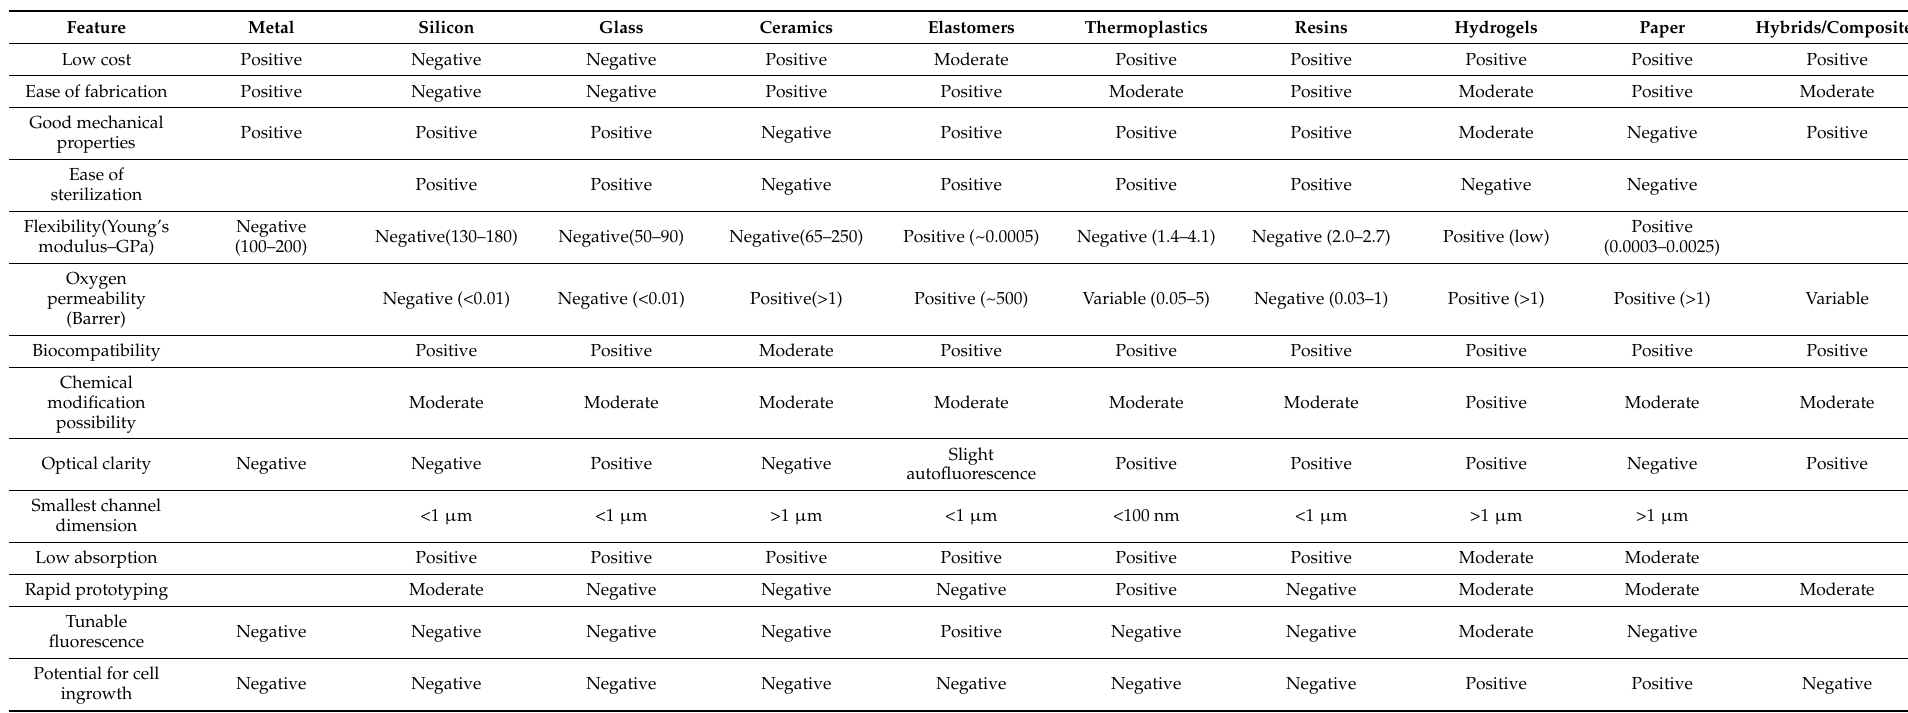
Table 1. Comparison of several available materials for the fabrication of microfluidic platforms. Adapted from the literature references